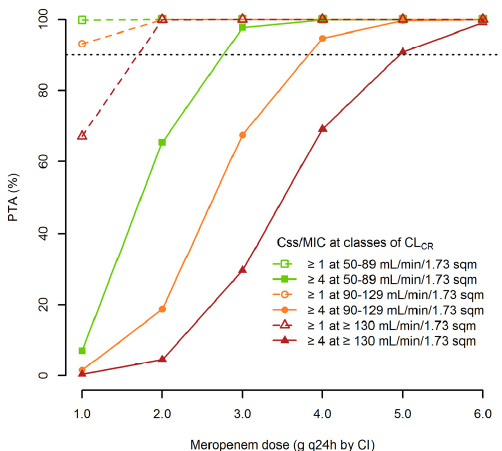
Figure 4. Probability of target attainments (PTAs) of Css/MIC ≥ 4 (solid lines) and Css/MIC ≥ 1 (dashed lines) at the EUCAST clinical breakpoint of 2 mg/L against Enterobacterales and P. aeruginosa with incremental dosages of continuous infusion meropenem in relation to different classes of CL CR . Horizontal broken line identifies the threshold for optimal PTA ( ≥ 90%).